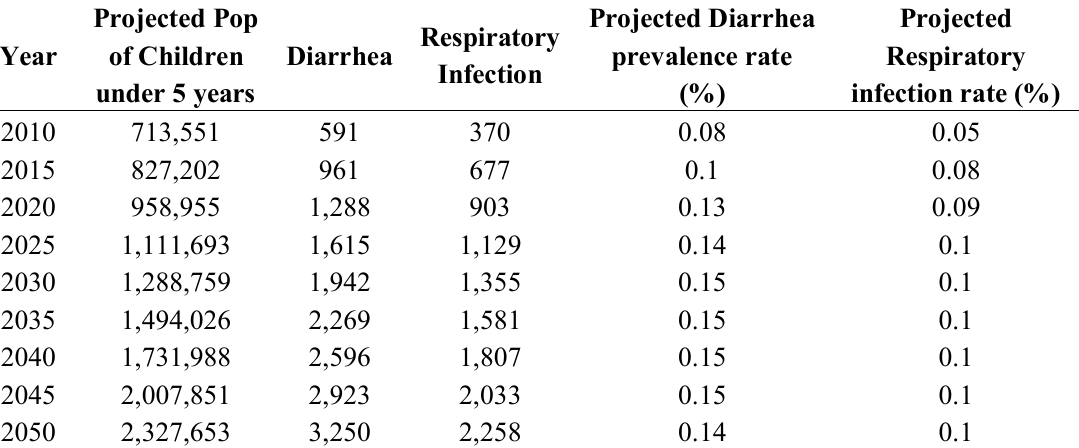
Table 5. Projected prevalence rates of diarrhea and respiratory